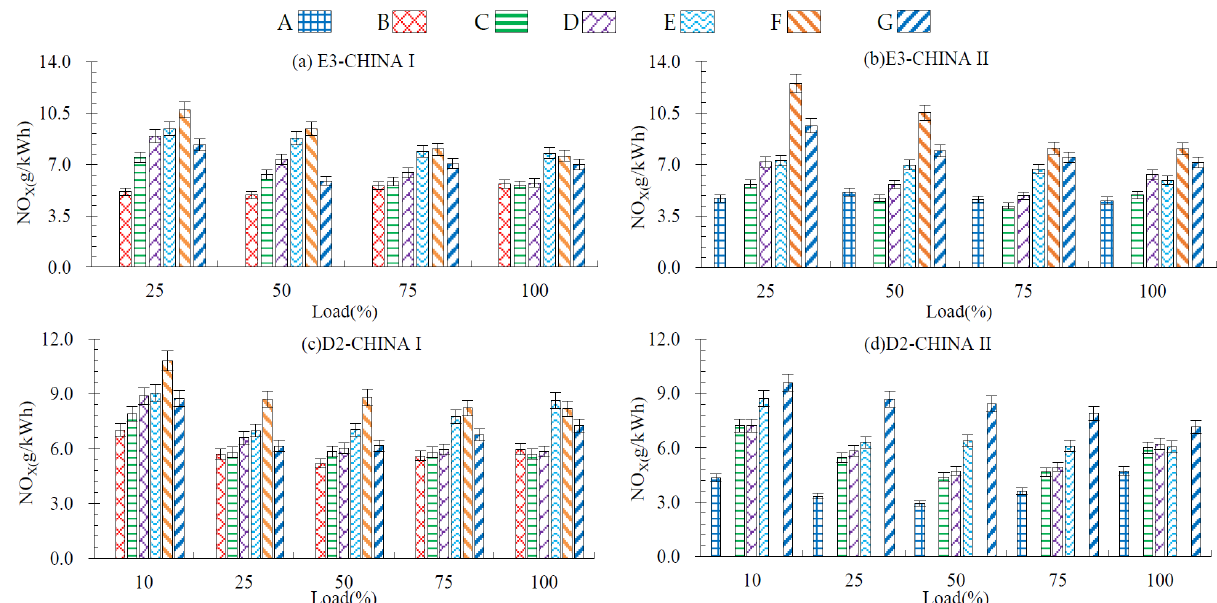
Figure 6. Relationship of NO X energy-based emission factors against load. ( a ) Specific emissions in the E3 cycle at four load points under the CHINA I standard; ( b ) Specific emissions in the E3 cycle at four load points under the CHINA II standard; ( c ) Specific emissions in the D2 cycle at five load points under the CHINA I standard; ( d ) Specific emissions in the D2 cycle at five load points under the CHINA II standard.